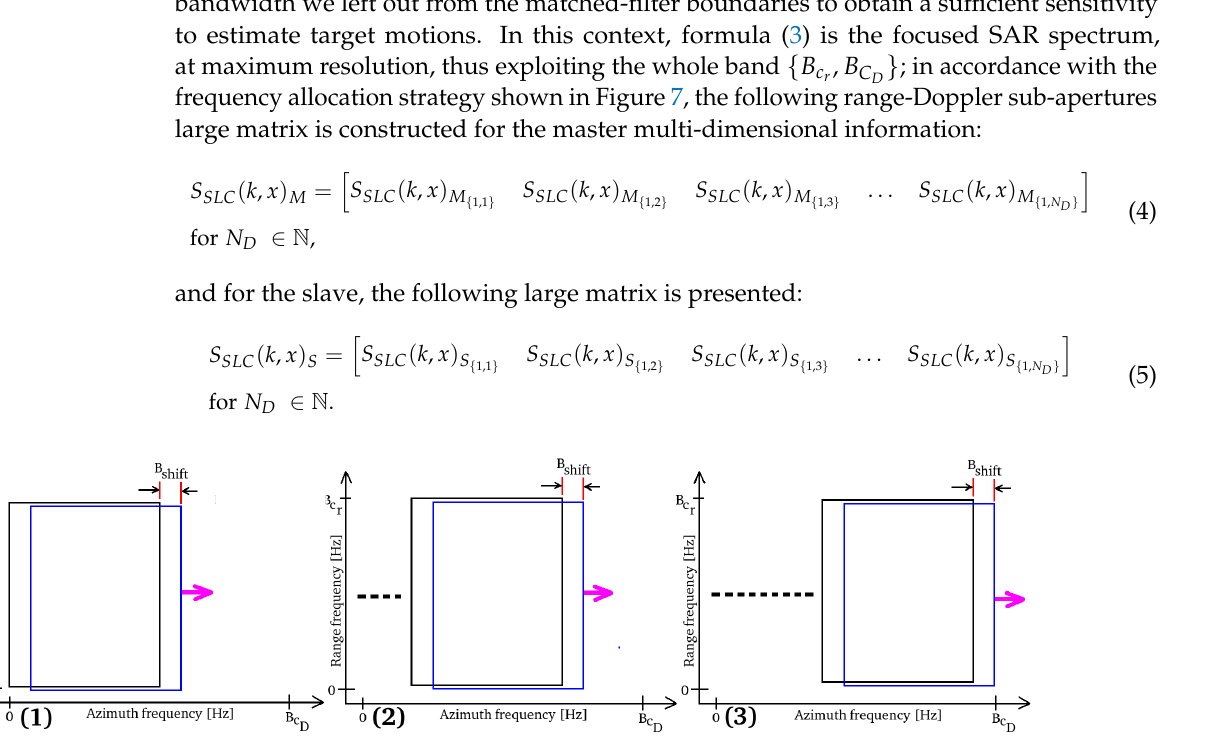
Figure 7. Doppler sub-aperture strategy. ( 1 ), ( 2 ), ( 3 ): Low, medium, high Doppler-frequency extrapo- lation